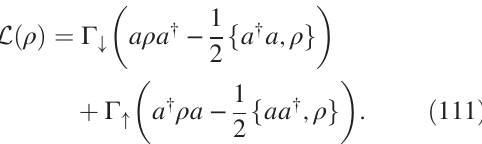
FIG. 6. Schematic picture of the setup. The intracavity mode H 0 is externally driven by a resonant laser field V weak contact with the environment at inverse temperature β , producing the emission and absorption of